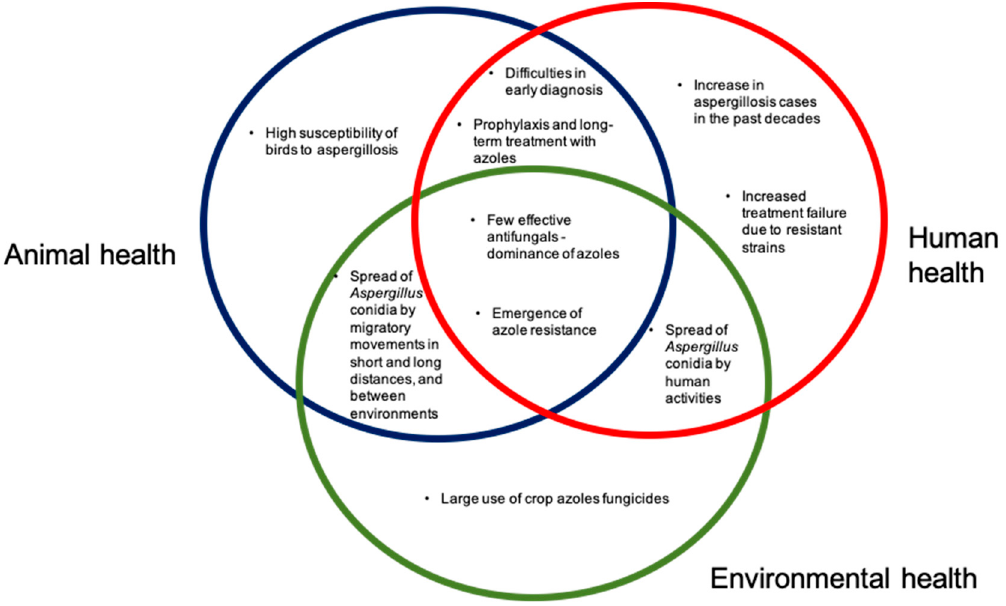
Figure 5. The One Health scheme, demonstrating the implications for Aspergillus and aspergillosis, in the environment, in animal health (with emphasis on birds), and in human